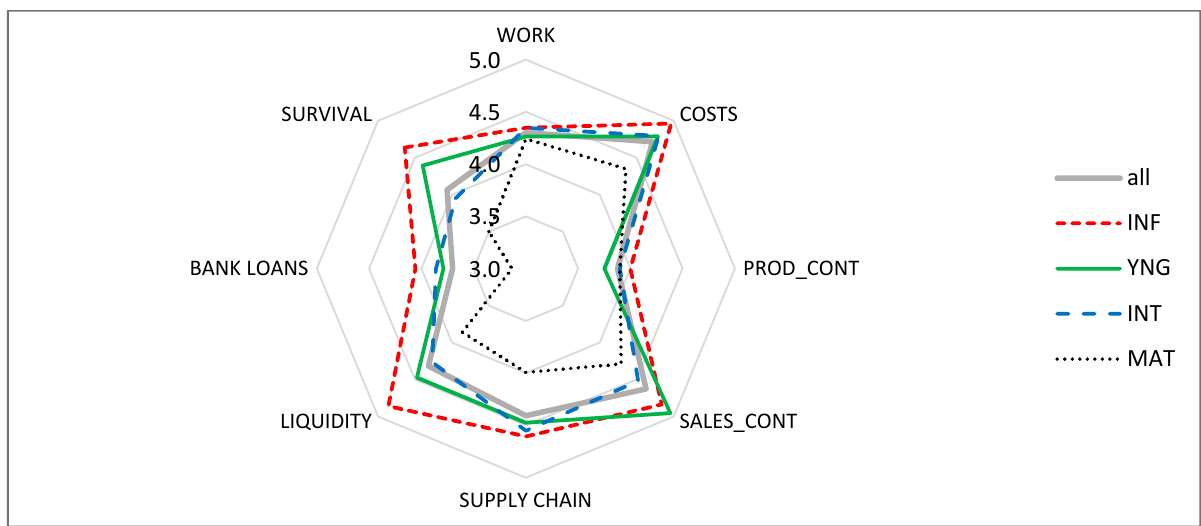
Figure 2. Perception of the COVID-19 interruptions and business age (AGE_1).